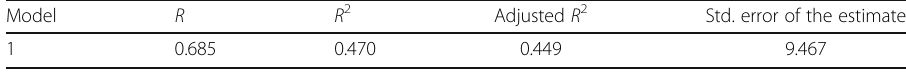
Table 8 Model summary for the language proficiency subskills as predictors of personal accomplishment